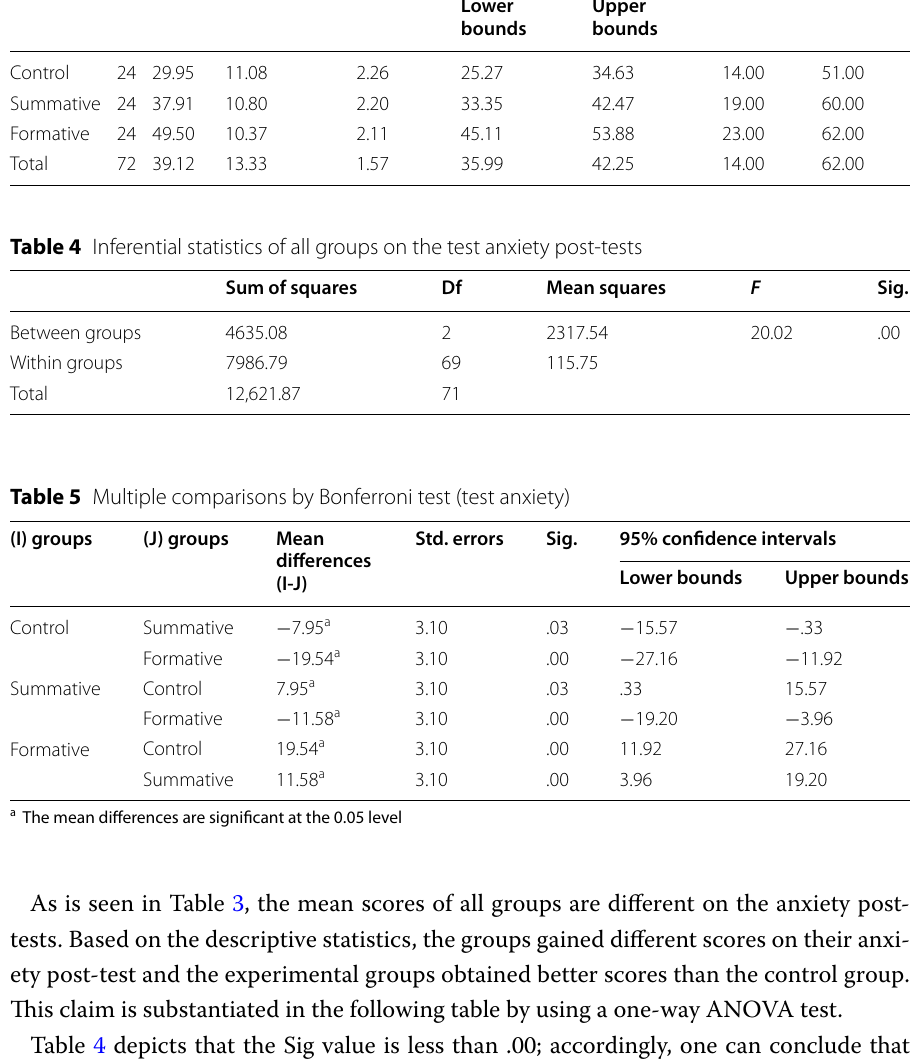
Table 3 Descriptive statistics of all groups on the test anxiety post-tests N Means Std. deviations